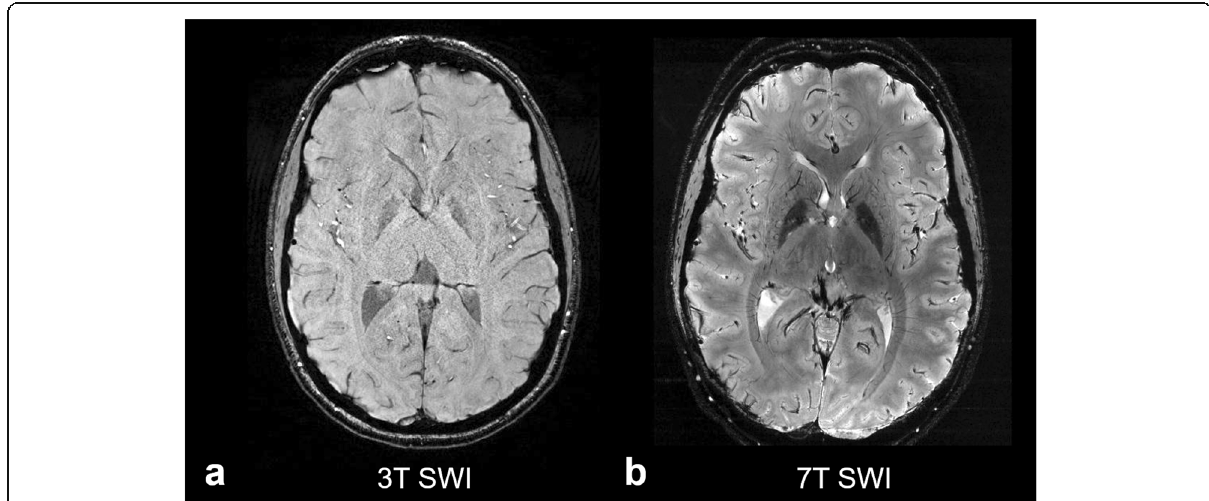
Fig. 1 Comparison of susceptibility-weighted imaging (SWI) using 3-T and 7-T magnetic resonance imaging. Axial SWI images are shown at the level of the basal ganglia in a healthy individual acquired at 3 T ( a ) and 7 T ( b ). At higher field strength, the shorter T2* relaxation times result in the greater SWI sensitivity to magnetic susceptibility differences in the blood vessels and mineralization in the basal ganglia, particularly in the globus